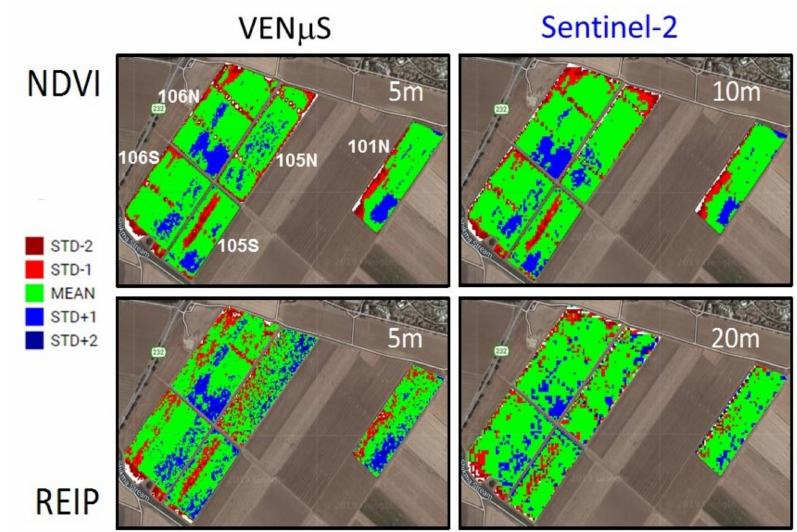
Figure 7. Anomaly Explorer app using a standard deviation of NDVI and REIP calculated from L1 VEN µ S (15/1/2019) and Sentinel-2 (16/1/2019) data in five wheat fields in Saad. Spatial resolution: VEN µ S 5 m; Sentinel-2 10 m (NDVI) and 20 m